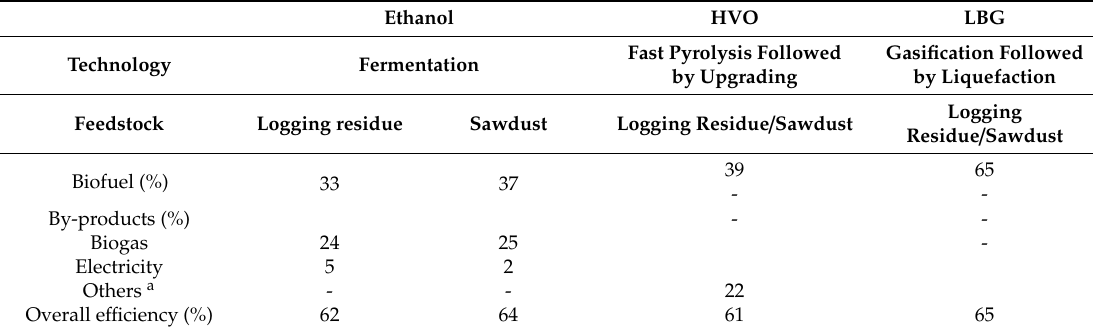
Table 2. Brief overview of conversion technology, conversion e ffi ciency (%) MJ LHV / MJ LHV, products and byproducts produced in di ff erent pathways.